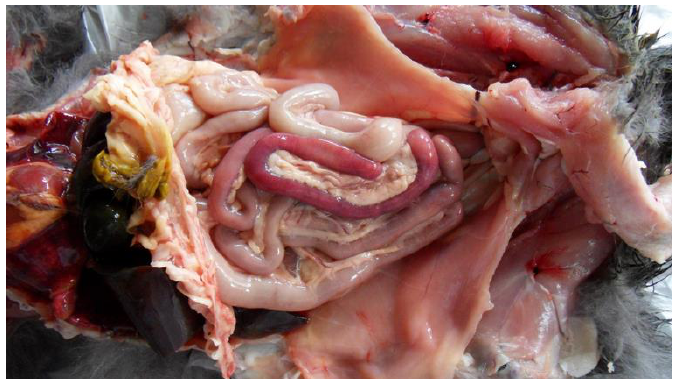
Figure 1. Cat abdominal cavity. Severe hyperemia of small intestine, jejunum, and ileum associated with edema of mesenteric lymph nodes.